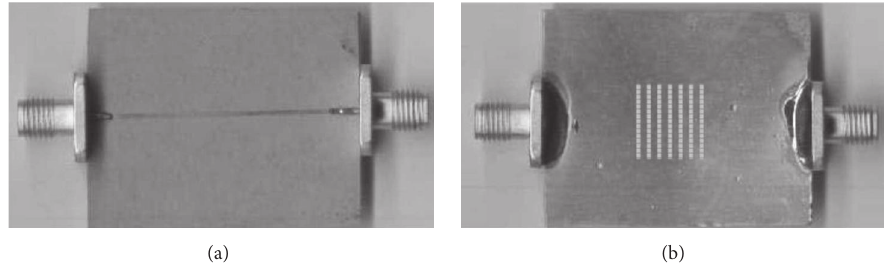
Figure 8: Photograph of a 7-cell microstrip slotted ground plane prototype. (a) Top view. (b) Bottom view